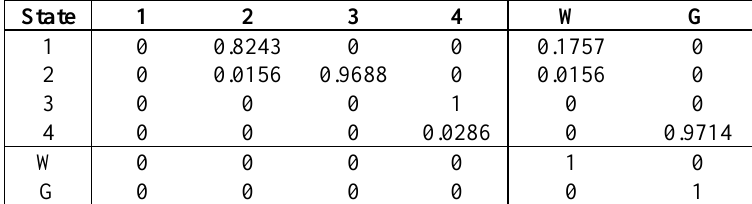
Table 7. The initial transition probability